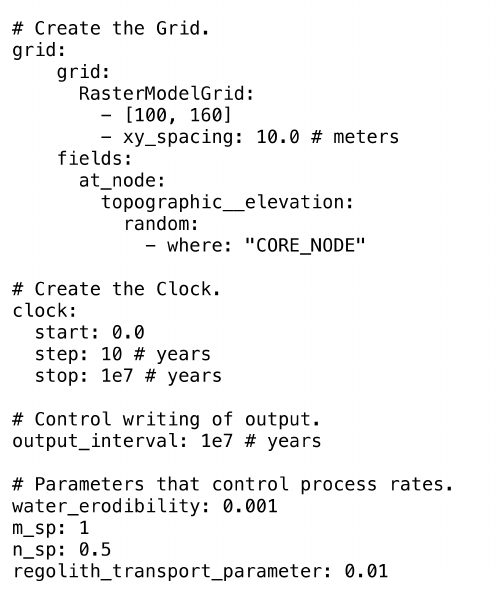
Figure 4. Example of a terrainbento input